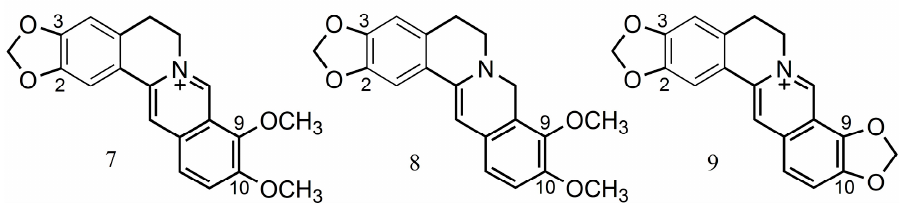
Figure 3. Chemical structures of berberine ( 7 ), dihydroberberine ( 8 ) and coptisine ( 9 ). In the case of alkaloids extracted from Lycopodium casuarinoides (lycoparins A ( 10 ), B ( 11 ) and C ( 12 )), the structure is also important in the inhibitory activity. Only lycoparin C ( 12 ) showed such an ability (Table 1), whereas lycoparins A ( 10 ) and B ( 11 ) have poor activity (IC 50 > 200 µ M) as a consequence of the occurrence of carboxylic acid at the C-15 and methyl substituents attached to N (Figure 4)